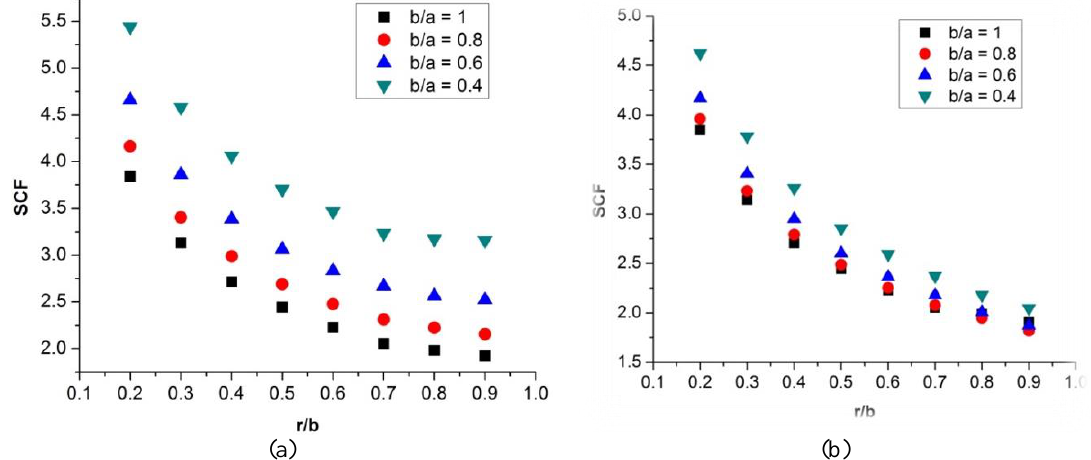
Figure 6. Variation of SCF in (a) X and (b) Y directions under biaxial